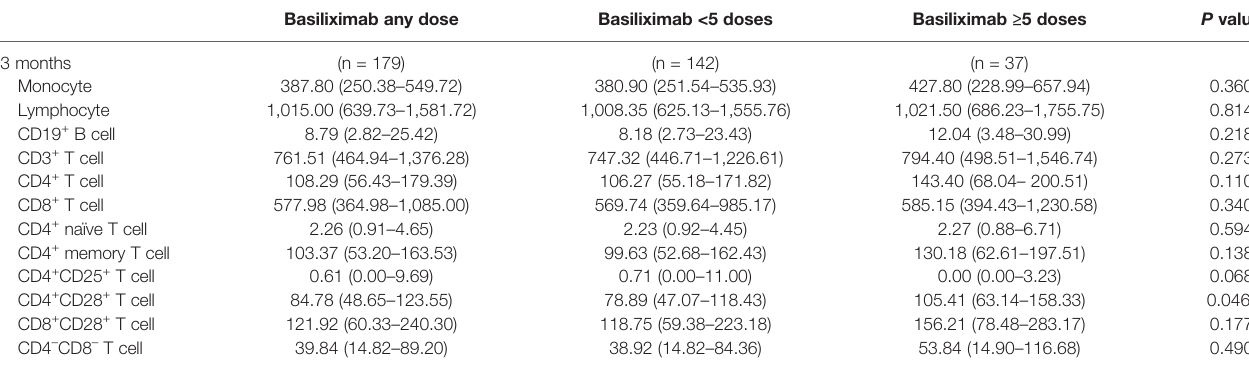
TABLE 3 | The values of immune cell subset counts at 3, 6, 9, and 12 months after HID HSCT [median (25th –